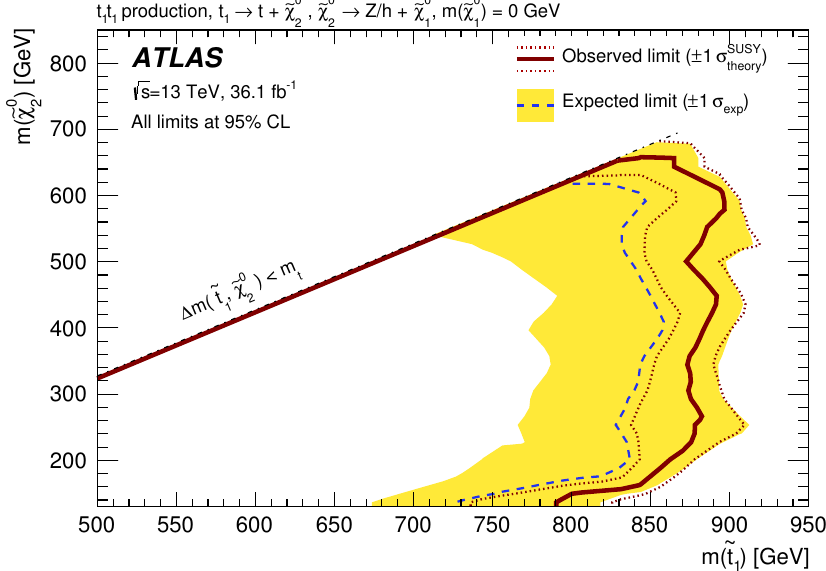
Figure 5. Exclusion limits at 95% CL from the analysis of 36 : 1 fb (cid:0) 1 of 13 TeV pp collision data on the masses of the ~ t 1 and ~ (cid:31) 0 2 , for a (cid:12)xed m (~ (cid:31) 0 1 ) = 0 GeV, assuming B (~ (cid:31) 0 2 ! Z ~ (cid:31) 0 1 ) = 0 : 5 and B (~ (cid:31) 0 2 ! h ~ (cid:31) 0 1 ) = 0 : 5. The dashed line and the shaded band are the expected limit and its (cid:6) 1 (cid:27) uncertainty, respectively. The thick solid line is the observed limit for the central value of the signal cross-section. The expected and observed limits do not include the e(cid:11)ect of the theoretical uncertainties in the signal cross-section. The dotted lines show the e(cid:11)ect on the observed limit when varying the signal cross-section by (cid:6) 1 (cid:27) of the theoretical